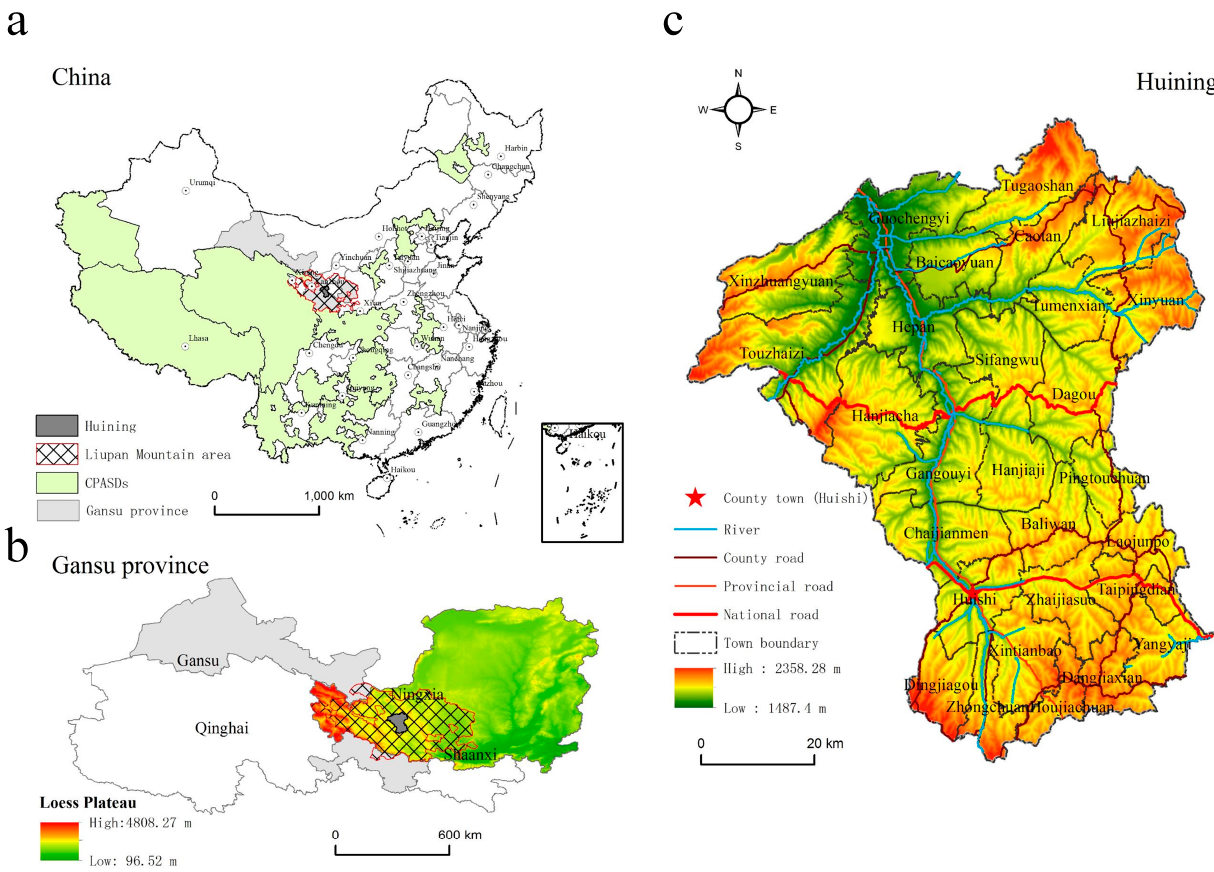
Figure 1. Location of Huining county. ( a ) The location of Huining county in China. ( b ) Location of Huining county in Loess Plateau. ( c ) Topography characteristics of Huining county.